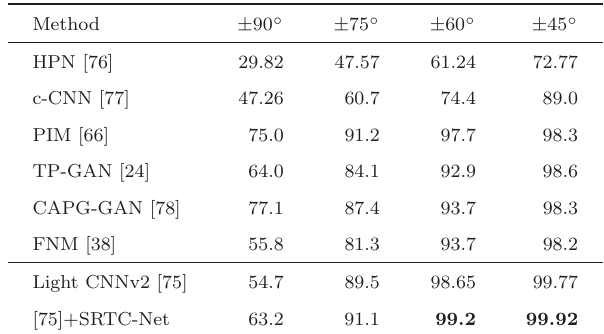
Rank-1 recognition rate (%) for varying views and illumination for Multi-PIE [63] Setting-1